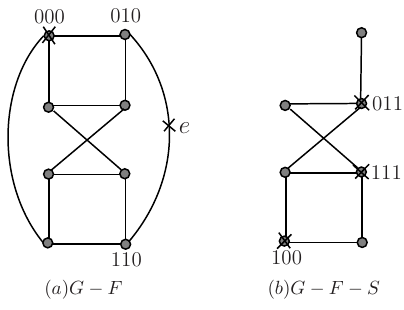
Fig.2 Illustration about the proof of Lemma